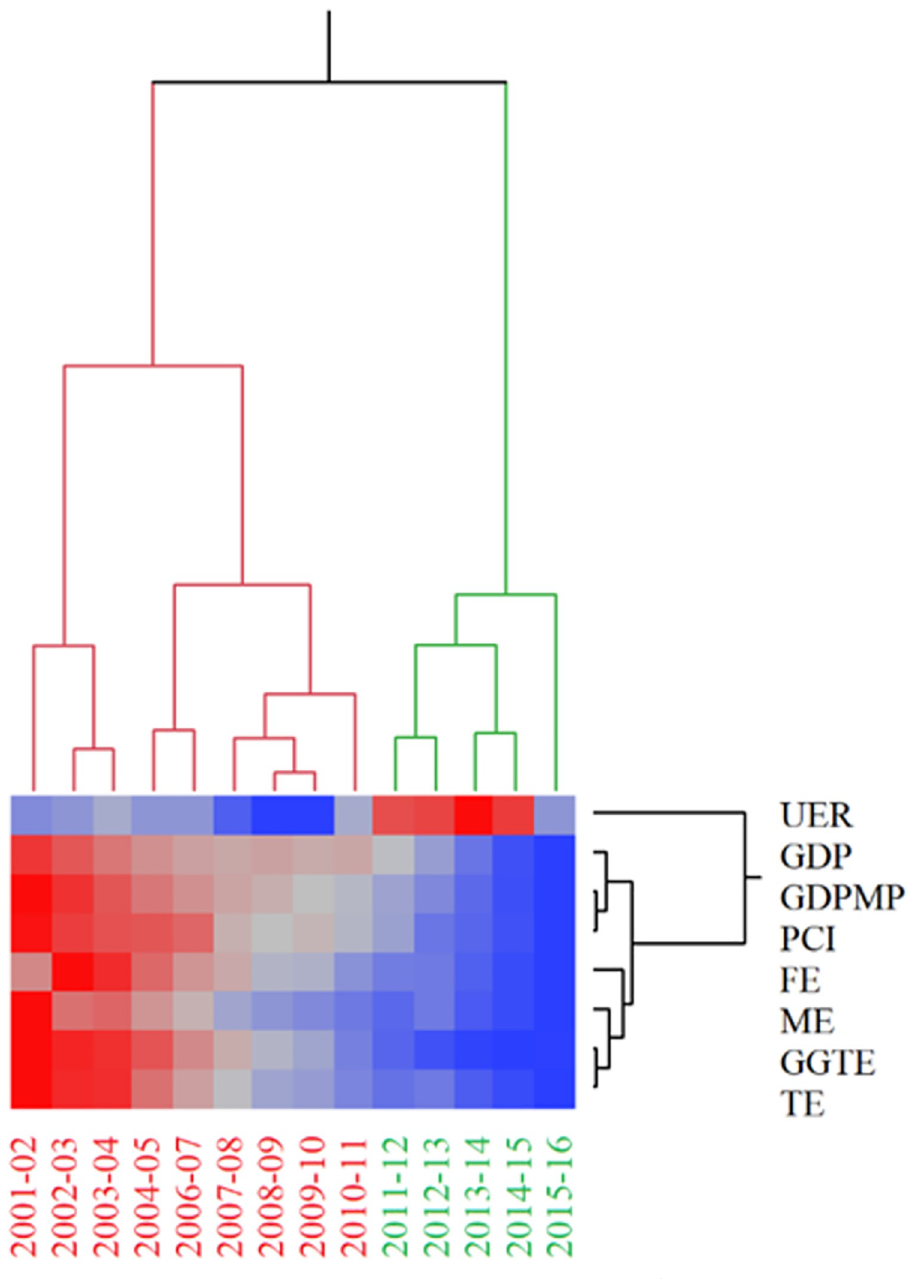
Fig 3. Dendrogram of cluster analysis of variables used in this study with Ward’s